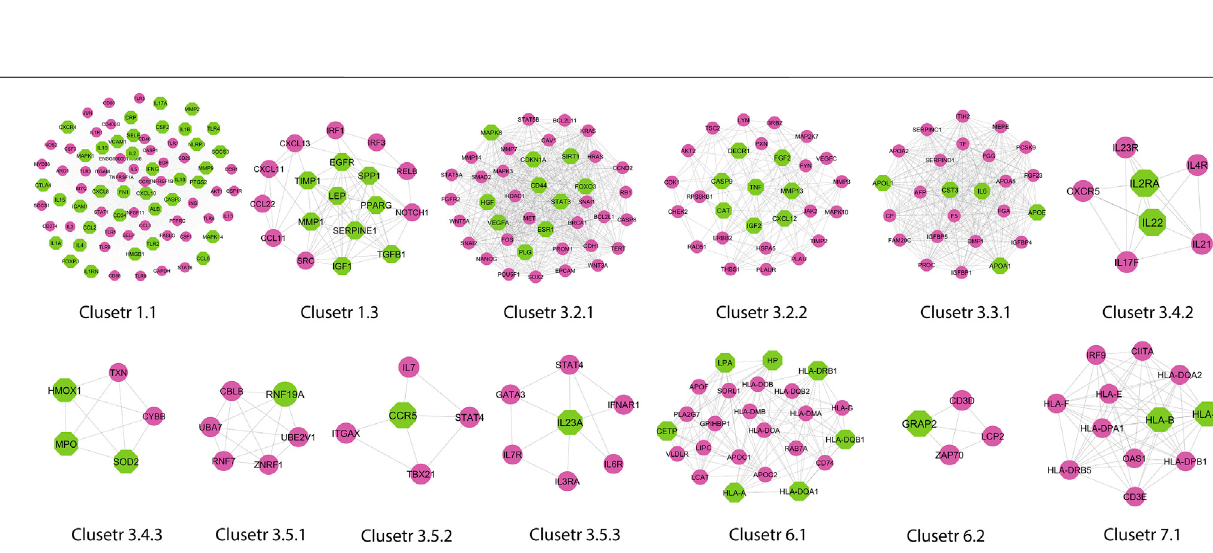
Frontiers in Pharmacology |